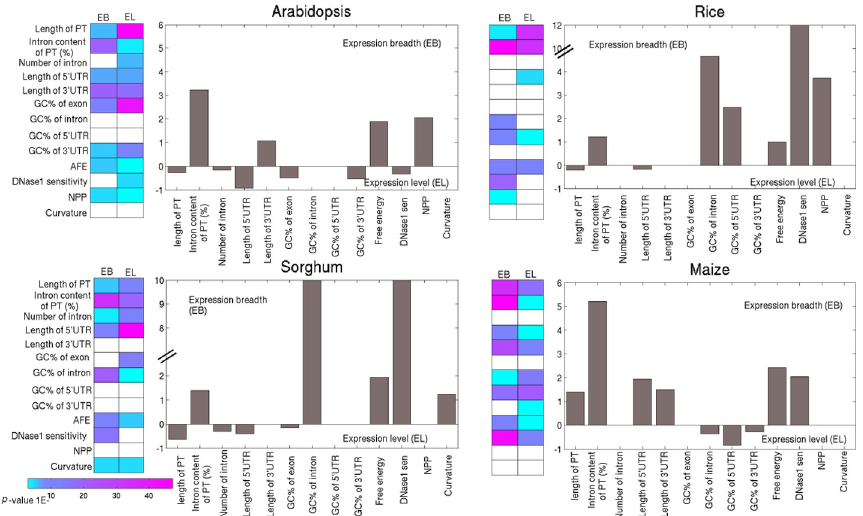
Fig 6. The influence of parameters on expression level or breadth is plotted for arabidopsis, rice, sorghum and maize. Ratios of the coefficient b1/b2 (from Table 3) are plotted only for significant p -values of either of the measures (breadth/level) with same sign. Corresponding p -values for breadth and level individually are shown on left of each plot with values increasing from cyan to magenta color (the empty color bar represents insignificant p -values).